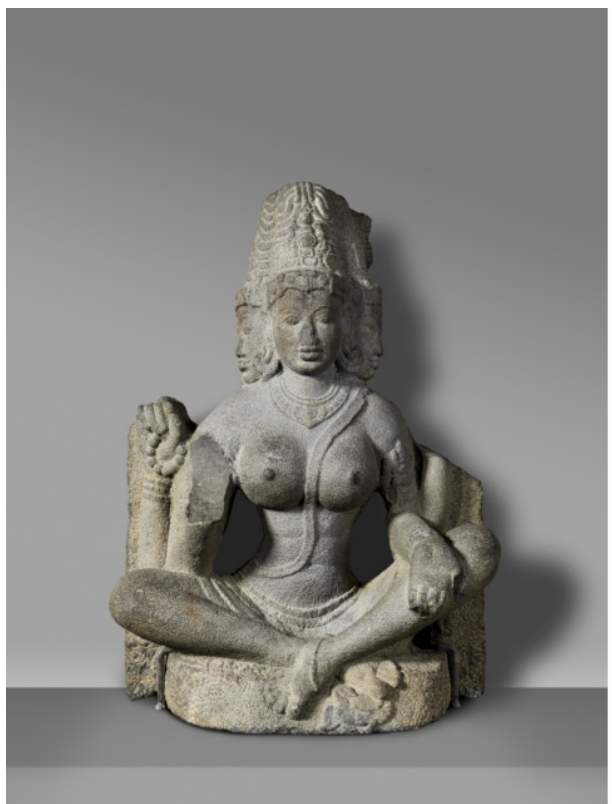
Figure 5. Brahmani, Tamil Nadu, ca. late 9th–mid-10th century. 29 × 21 × 10 in. (73.2 × 53.3 × 25.4 cm). Asian Art Museum, San Francisco, The Avery Brundage Collection, B60S47+. Photograph © Asian Art Museum of San Francisco.